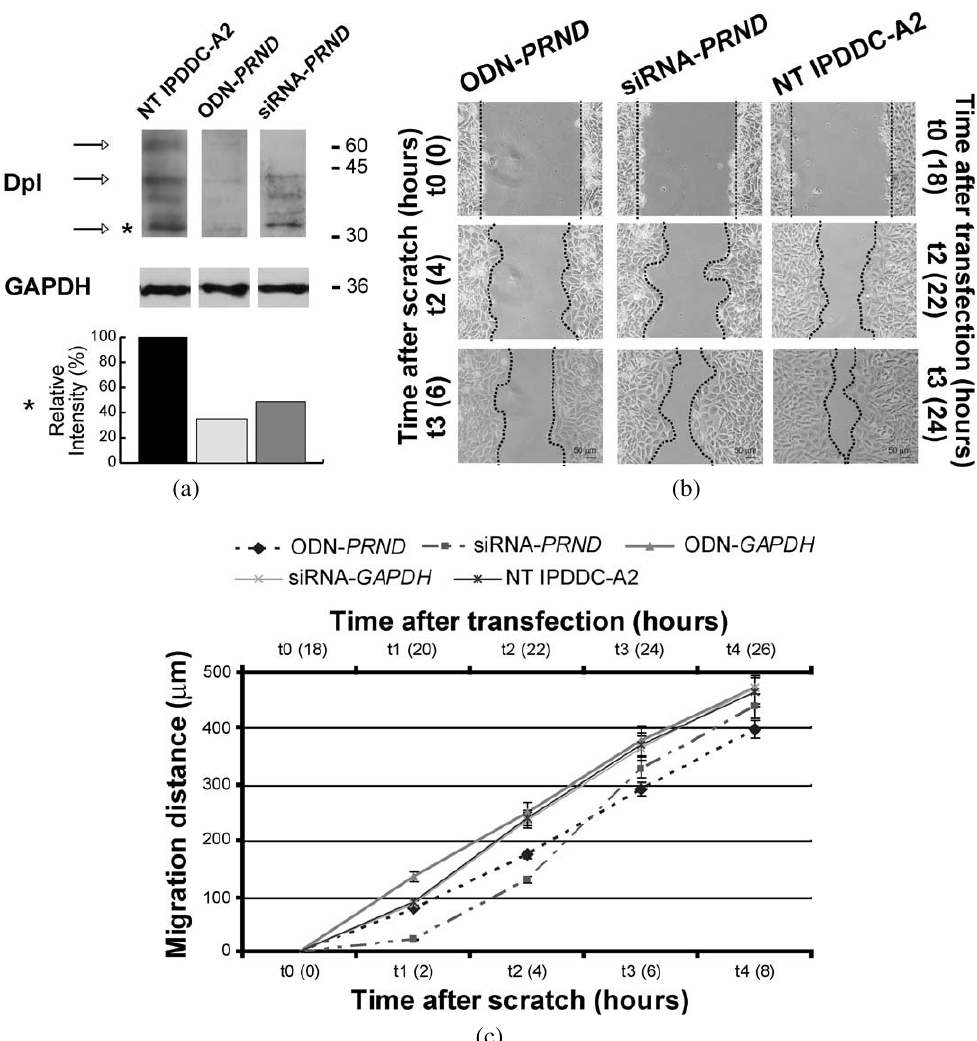
Fig. 1. IPDDC-A2 cells treatment with Dpl-silencing molecules and migration rate curves. (a) Doppel (Dpl) and GAPDH immuno-blot analysis of Dpl-silenced cell lysates, 24 h after transfection with PRND -specific S-ODN (ODN- PRND ) and siRNA (siRNA- PRND ), revealed an expression decrement of the three Dpl major isoforms (indicated by the arrows). The histogram reports the percentage relative intensities of the 30 kDa band (*), taken as representative band, normalized to the untreated sample (NT IPDDC-A2). Bands molecular weights are indicated in kDa. (b) The snapshots of the cell monolayer scratches indicate the higher migration rate of the untreated cells respects to the Dpl-silenced cells, respectively, at 4 h after scrape (i.e. 22 h after transfection) and at 6 h after scrape (i.e. 24 h after transfection). Scale bars are reported (50 µm). (c) The graphical representations of the migration curves show that both S-ODN (ODN- PRND ) and siRNA (siRNA- PRND ) treatment influences the migratory behaviour of IPDDC-A2 cells reducing the migration capability, while GAPDH -specific silencing treatment (ODN- GAPDH and siRNA- GAPDH ) does not affect migration, being similar to the untreated control (NT IPDDC-A2). In particular, siRNA- PRND treatment shows the phenotypic effect earlier than ODN- PRND treatment, while an inverted trend is observed 5 h after scratch (i.e. 23 h after transfection). Statistical analysis was performed by Student’s t test ( p < 0 .